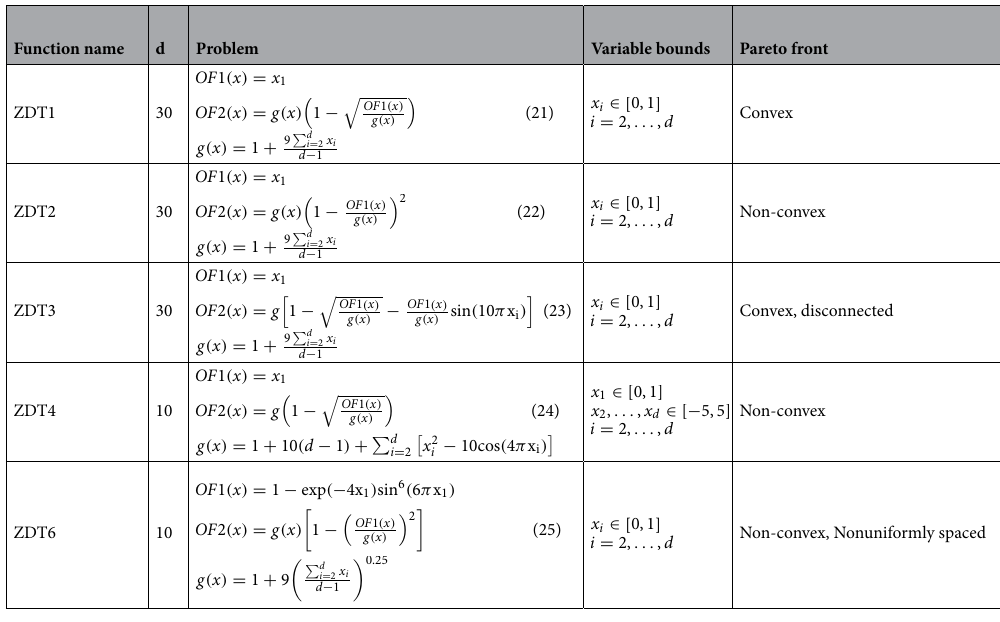
Table 1. ZDT multi-objective test function suite 39 (Incidentally, due to being binary encoded, ZDT5 has often been omitted from analysis elsewhere in the EA literature.